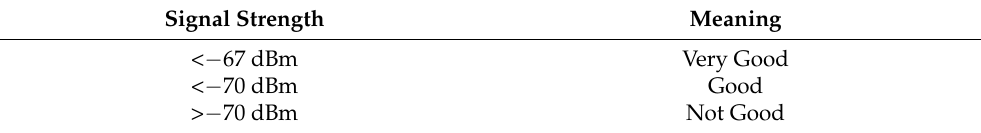
Table 1. RSSI table. Signal